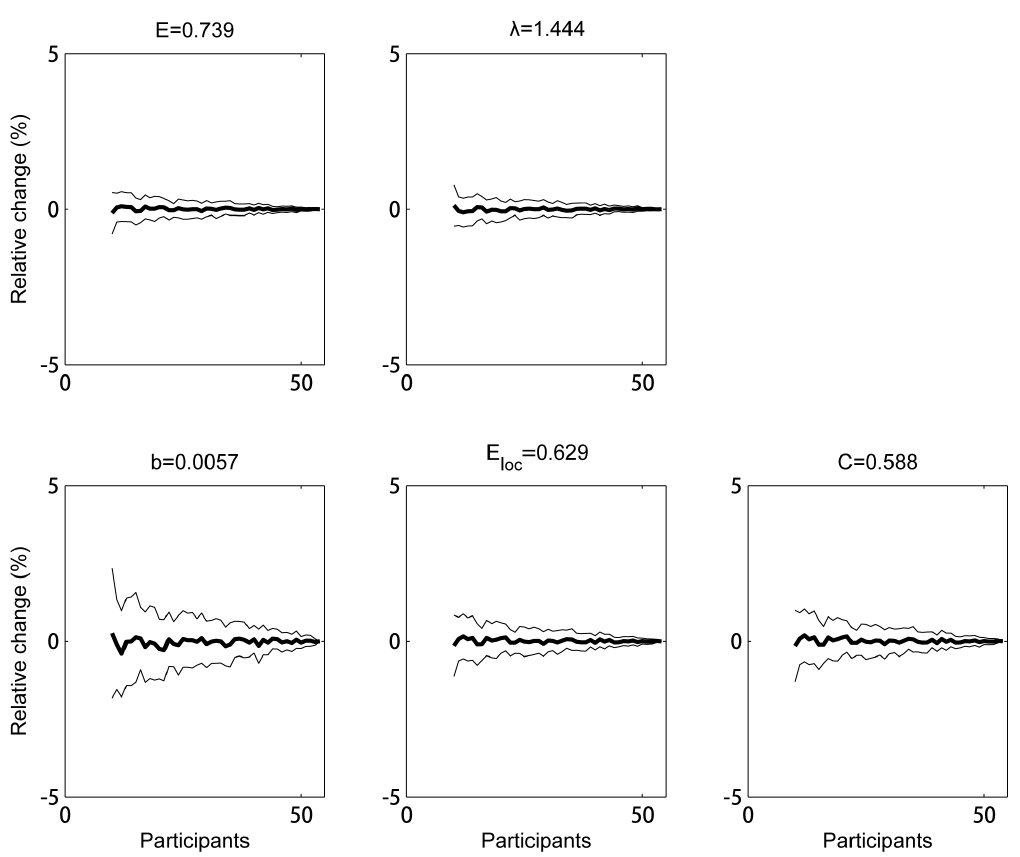
Fig. 6. Group size effect for groups of individual networks. The average across subjects of the weighted graph measures determined from the individual’s network is shown as function of group size. A bootstrapping procedure was used (100 realizations) to randomly group the subjects with increasing group size. For graph measures the relative change (%) to the reference value (which is obtained by averaging across all subjects) are shown. Full lines denote the mean (bold) + standard deviation of the metric. Dotted lines represent a relative change of + 10%. E : global efficiency; l : the characteristic path length; b : the mean betweenness centrality; E loc : the mean local efficiency and C : the mean clustering coefficient.